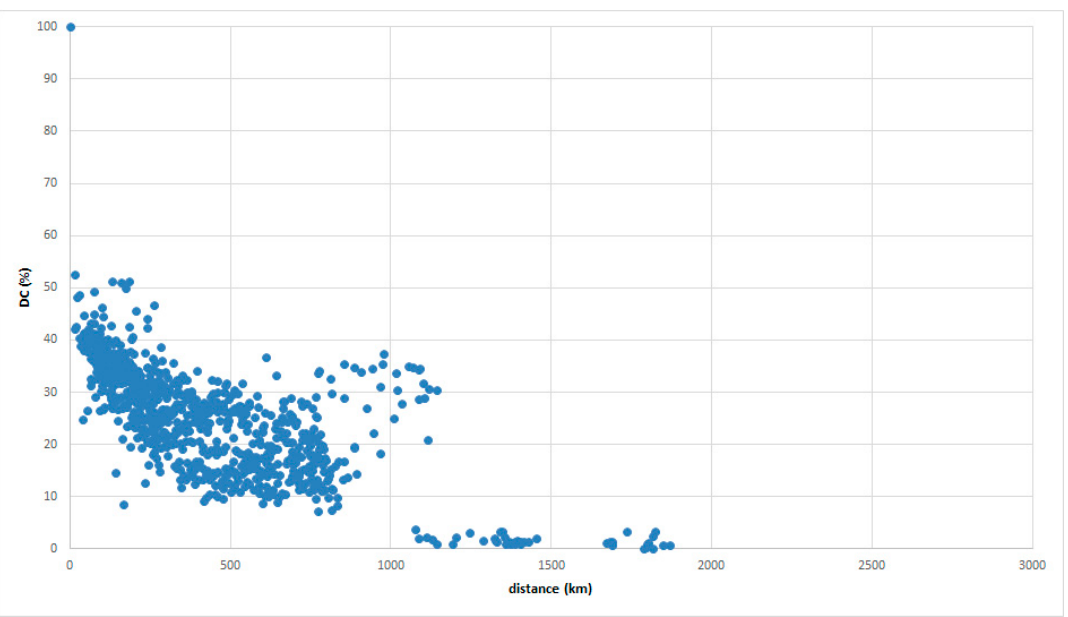
Figure 7. GAJ data with reference place in Tokaitosan.